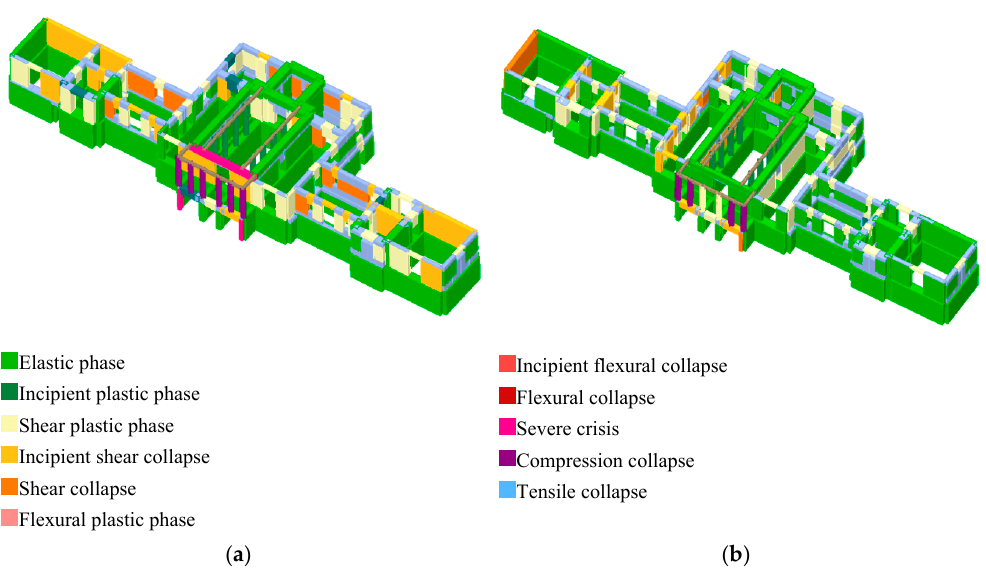
Figure 10. Failure mode according to the worst condition in the X ( a ) and Y directions ( b ).